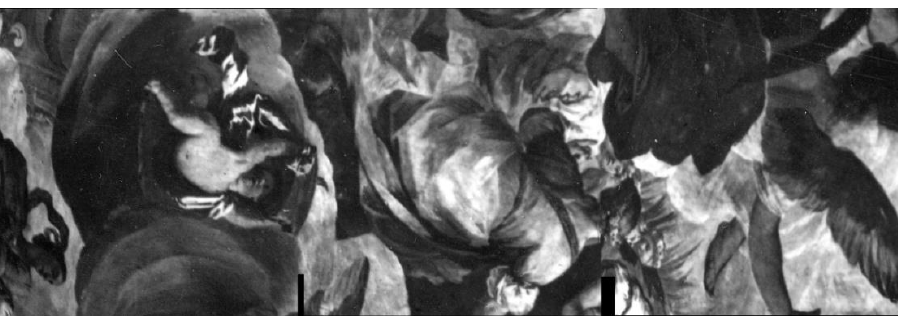
Figure 10. Image calculated from one of the video projection positions (details of the mesh portion).